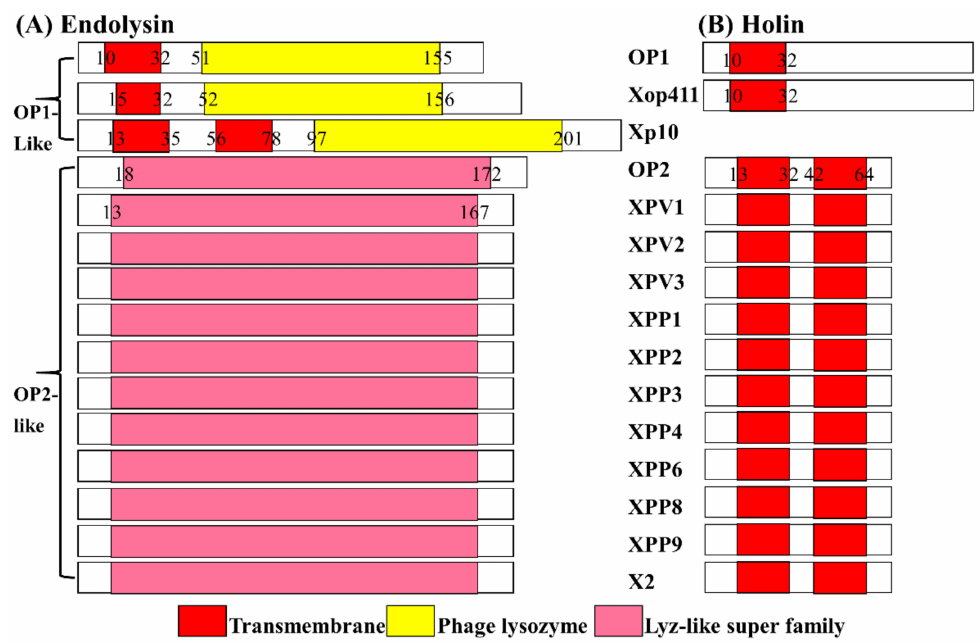
Figure 4. Comparison of lysis system between OP1-like and OP2-like phages of Xoo. ( A ) Endolysin. ( B )